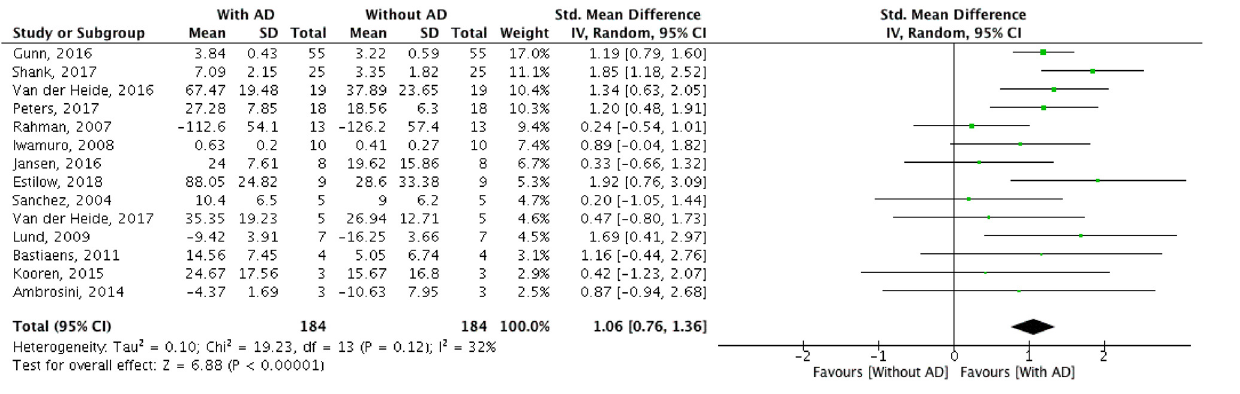
Weights are computed with (Equation 6) and expressed as